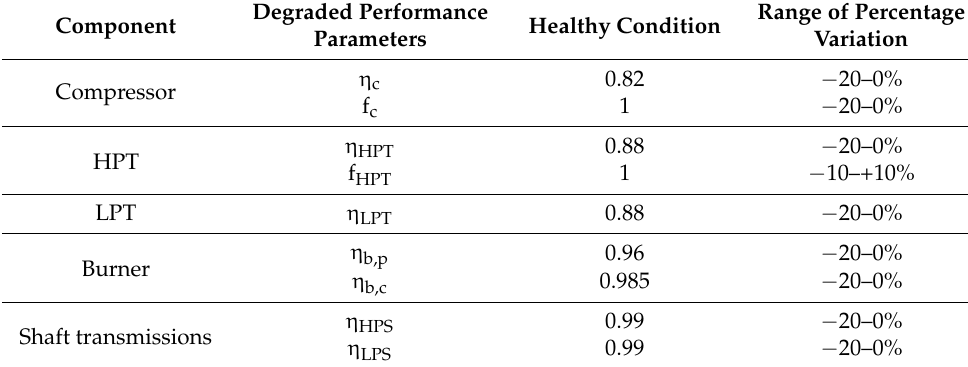
Table 2. Performance Parameters of each degraded component. η c : compressor polytropic efficiency; f c : compressor flow capacity; η HPT : HPT polytropic efficiency; f HPT : HPT flow capacity; η LPT : LPT polytropic efficiency; η b,p : burner pneumatic efficiency; η b,c : burner combustion efficiency; η HPS : high-